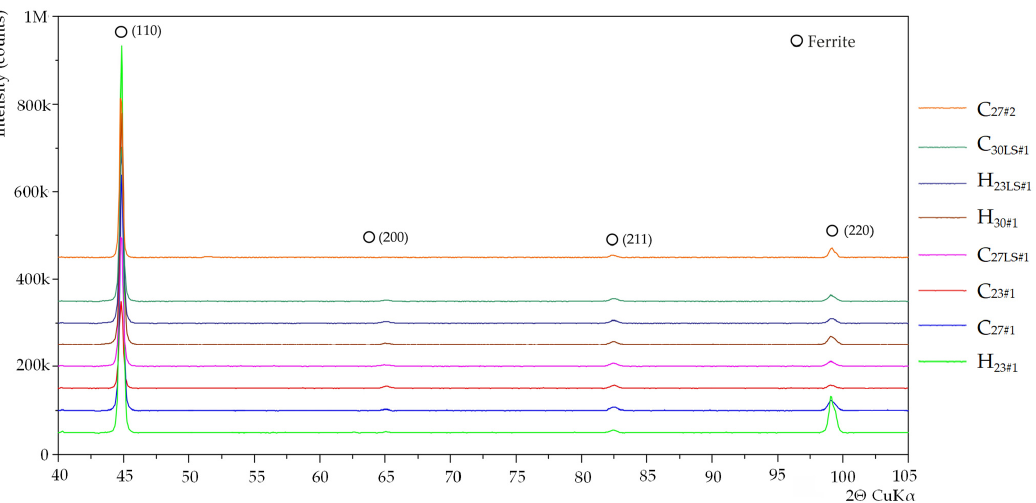
Figure 3. Elemental mapping of cross-section of surface layer of H 23#1 obtained during the carried- out tests. EDS.